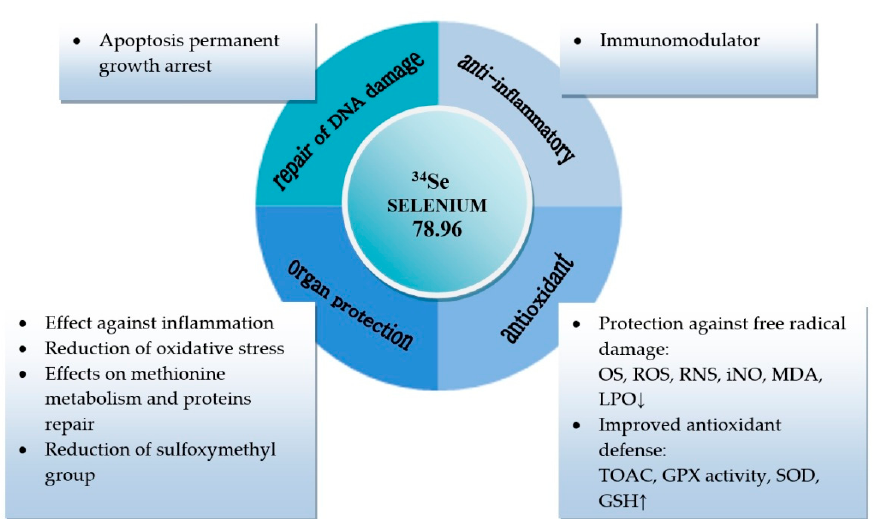
Figure 1. Role of selenium in organ function. OS, oxidative stress; ROS, reactive oxygen species; RNS, reactive nitrogen species; iNO, inhaled nitric oxide; MDA, malondialdehyde; LPO, lipid peroxidation; SOD, superoxide dismutase; TAOC, total antioxidant capacity; GPX; glutathione peroxidase; GSH, glutathione.